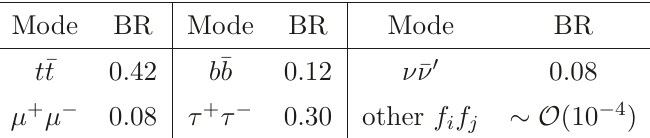
Table 2 . Z 0 branching ratios (BRs) in the Third Family Hypercharge Model example case. We have neglected fermion masses and lumped all (cid:13)avours of neutrino into (cid:23) , (cid:23) 0 . The BRs to other fermion pairs are highly suppressed; for example, the next largest BR is to t (cid:22) c pairs, for which the BR is (cid:24) O (10 (cid:0) 4